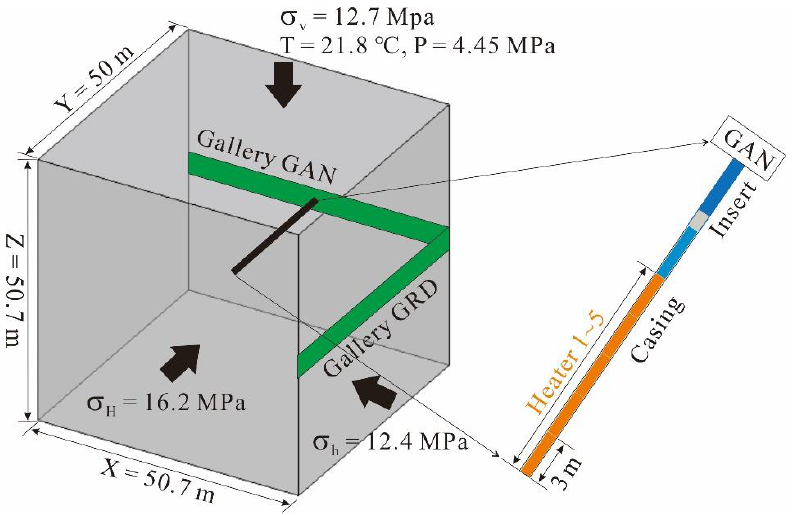
Figure 6. The 3D conceptual model of the ALC1604 experiment with initial and boundary conditions.